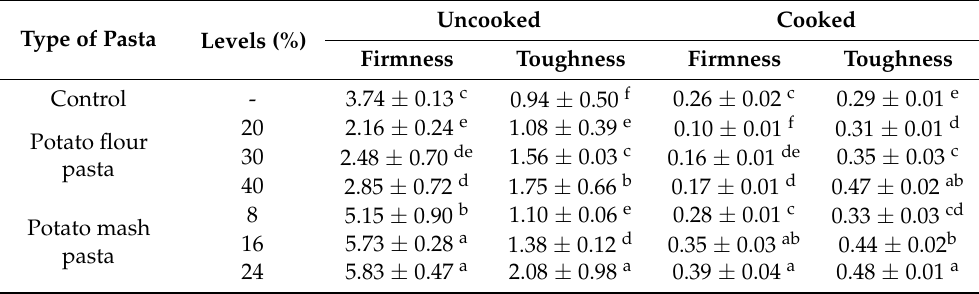
Table 6. Effect of replacing potato powder and mash with semolina on the textural attributes of